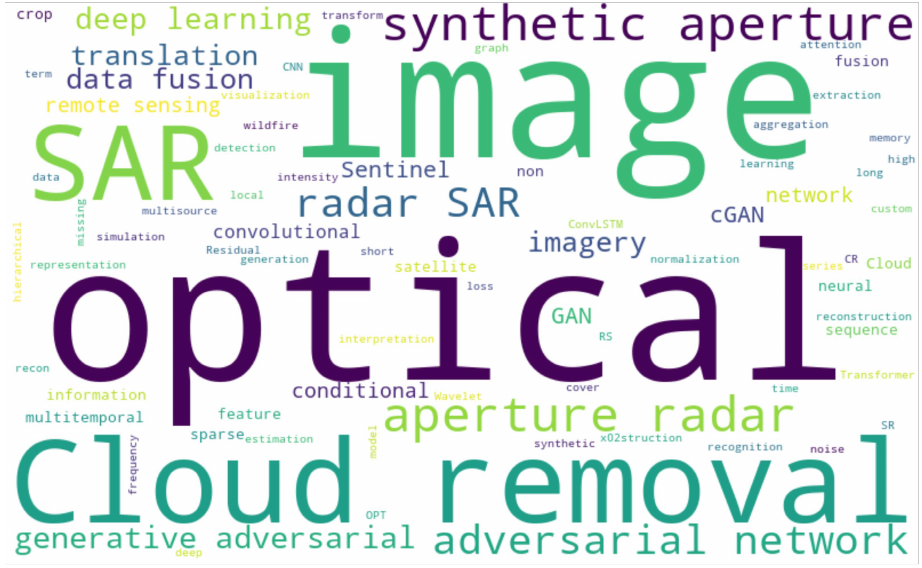
Figure 3. A tag cloud of the literature titles of the 26 journal papers about the cloud removal from optical remote sensing imageries using SAR, where a larger font and darker color denote a higher frequency.